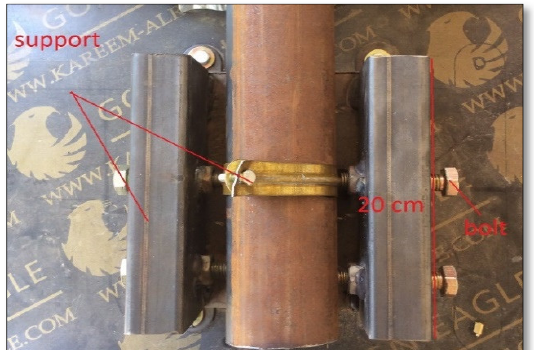
Fig. 8. Show number of cycle of 100cm specimens.